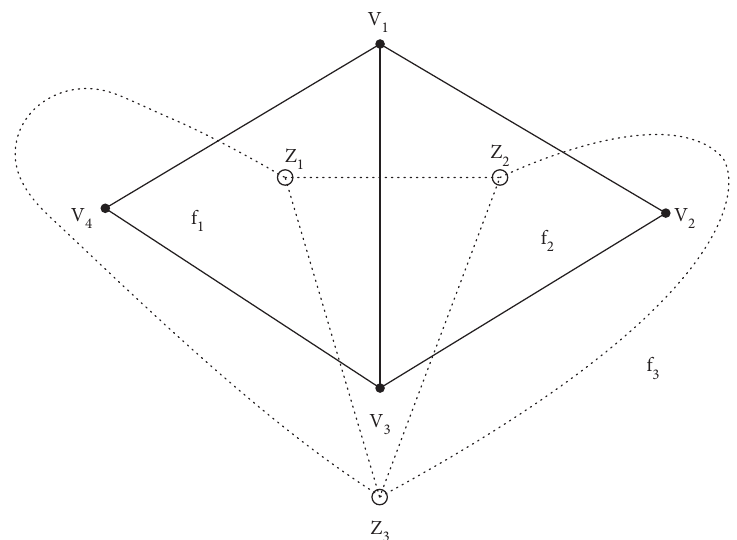
Figure 6: Complex q-rung orthopair fuzzy dual graph of the